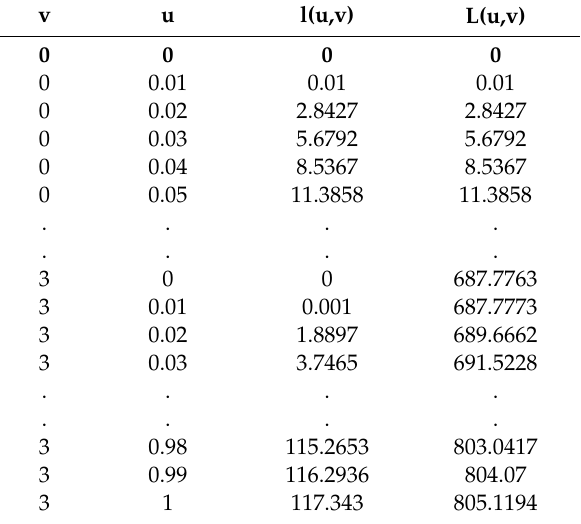
Table 1. Data for converting between arc length and curve